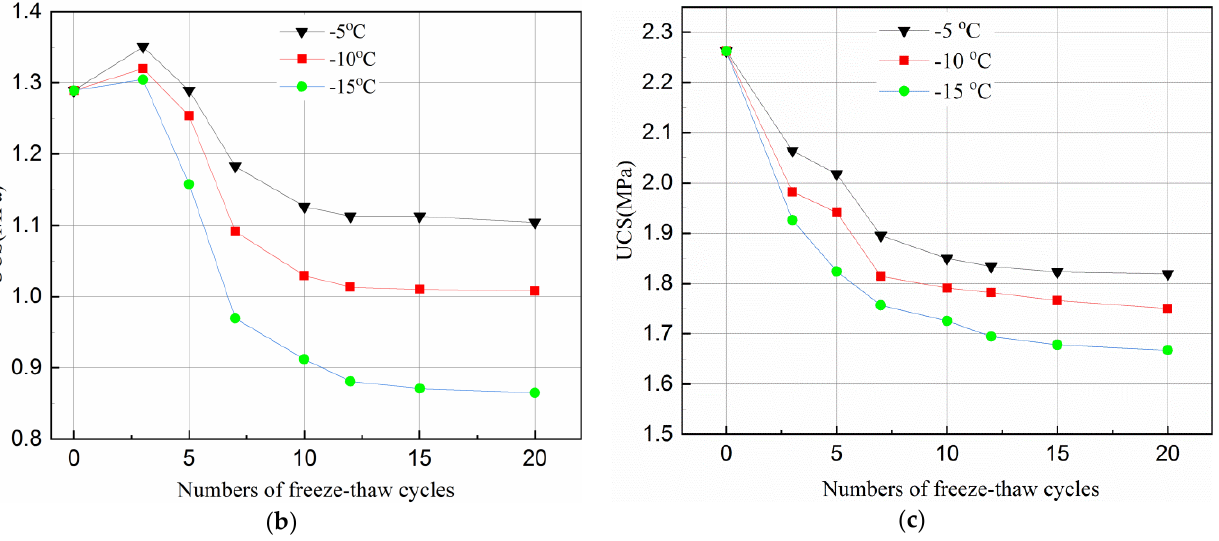
Figure 2. Effect of freeze–thaw cycles on UCS of tailings samples for different curing time and temperature. ( a ) After 3-day curing; ( b ) After 7-day curing; ( c ) After 28-day curing.